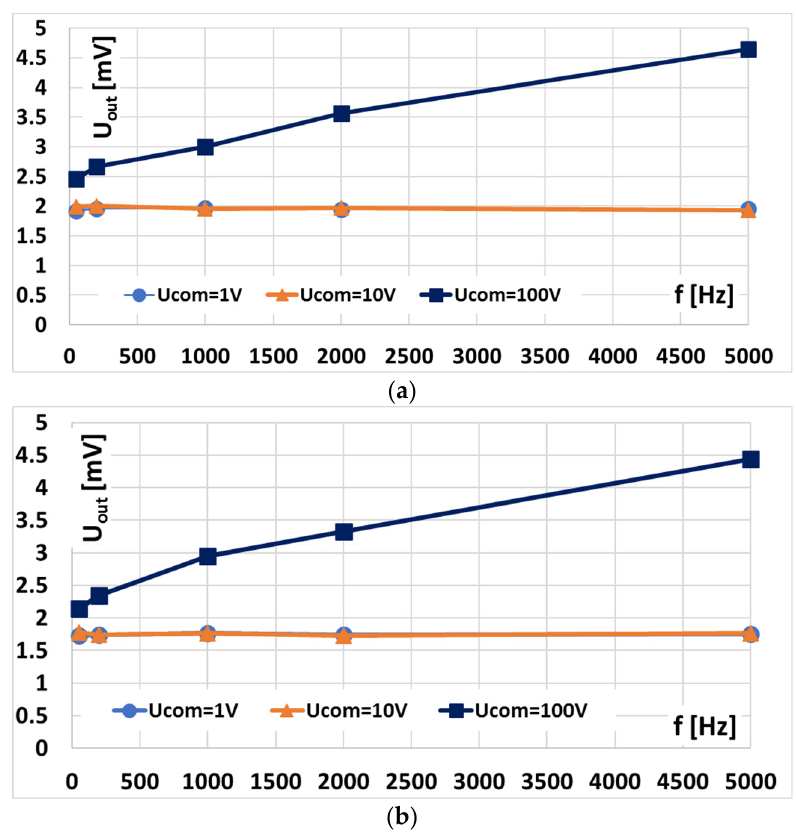
Figure 4. ( a ) The 1st opto-isolation circuit calibration of the zero output voltage vs frequency of the differential input voltage at various level of common voltage. ( b ) The 2nd opto-isolation circuit cal- ibration of the zero output voltage vs frequency of the differential input voltage at various level of common voltage.